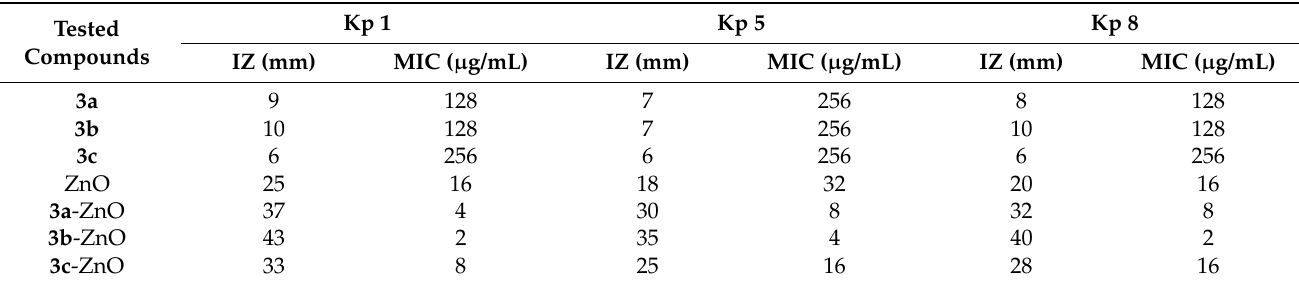
Table 5. Antibacterial activity of the synthesized compounds vs. their